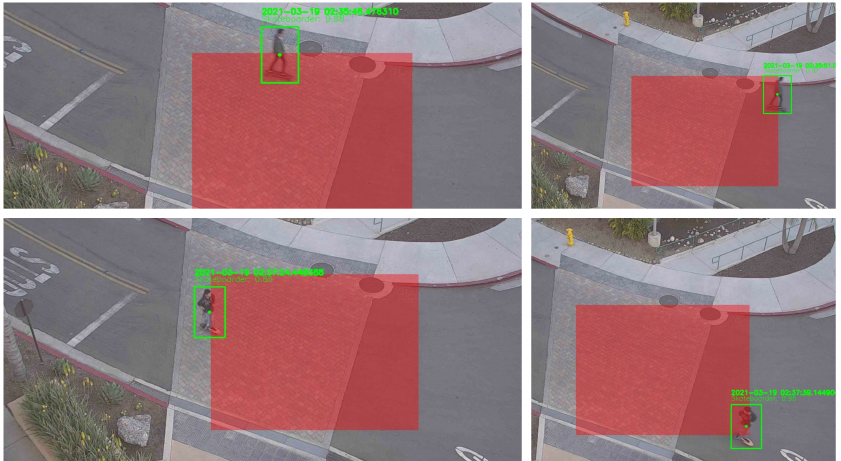
Figure 21. A pair of skateboarders entering and leaving a superimposed artificially created conflict zone shown in red one after another and their ingress and egress timestamps are